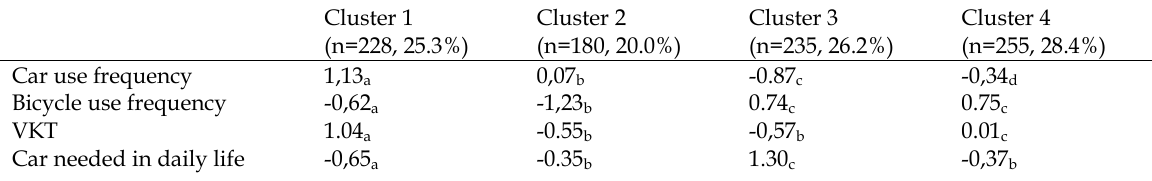
Table 2: Final cluster centres of constituent variables (subscript indicates which cluster centres are significantly different from the other values in the same row of the table,